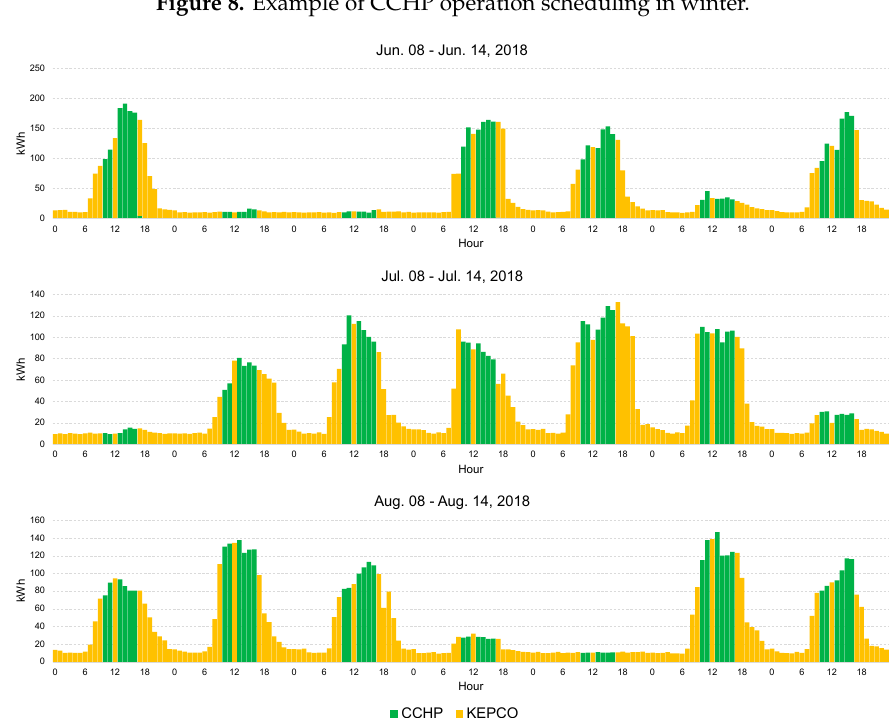
Figure 9. Example of CCHP operation scheduling in summer.